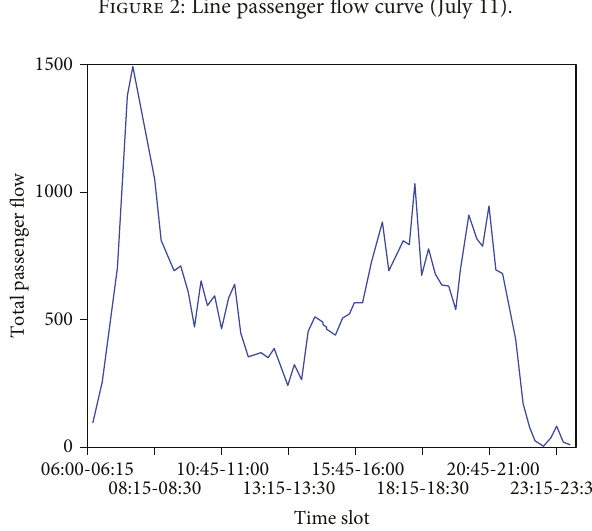
Figure 2: Line passenger fl ow curve (July 11).